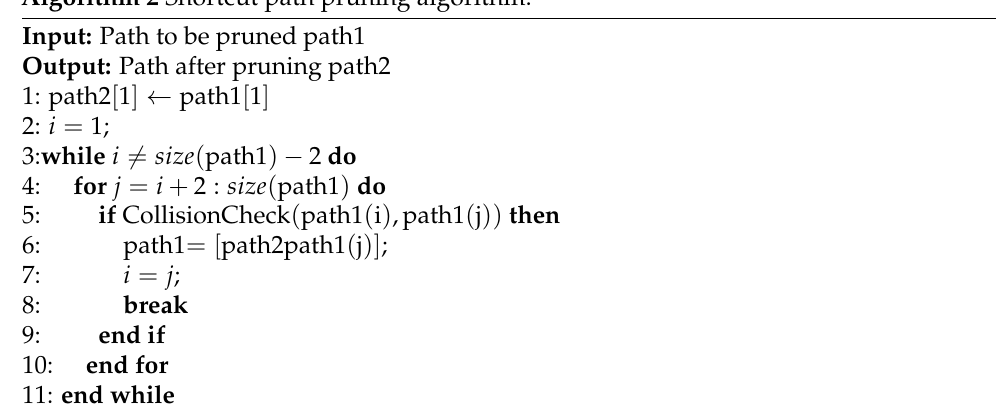
Figure 3. Schematic diagram of path pruning. Algorithm 2 Shortcut path pruning